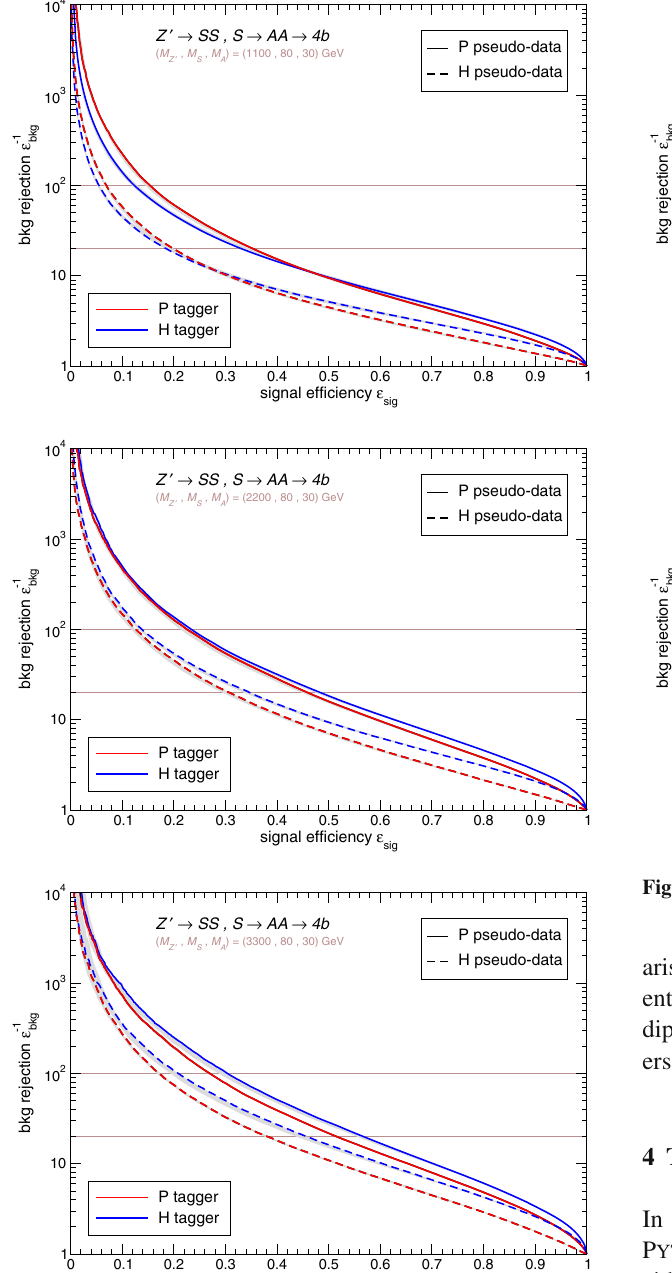
Fig. 4 ROC curves for 4P jets with m J ∼ 80 GeV